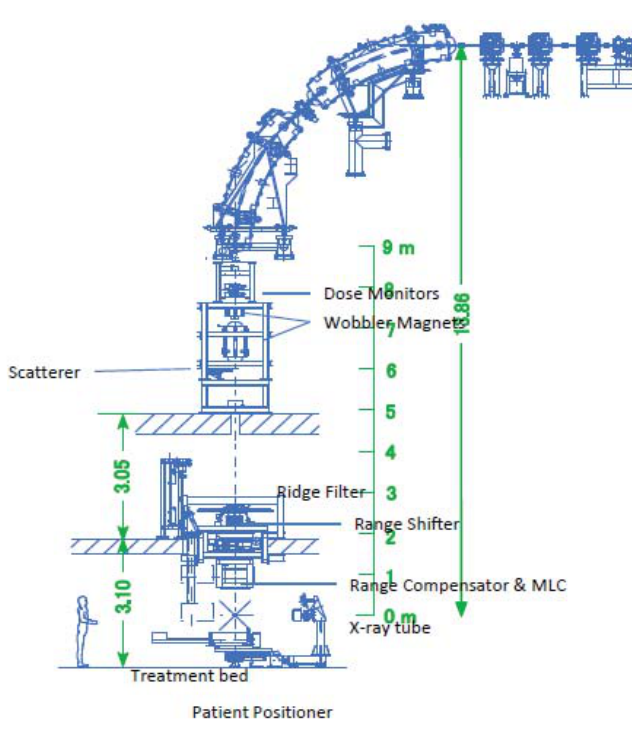
Figure 4. Beam delivery system.